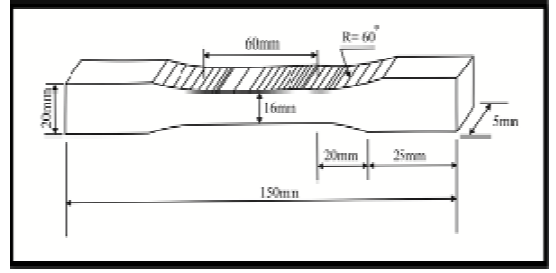
Fig. 6. Schematic Specimen for Standard Specimen of Tensile Test.